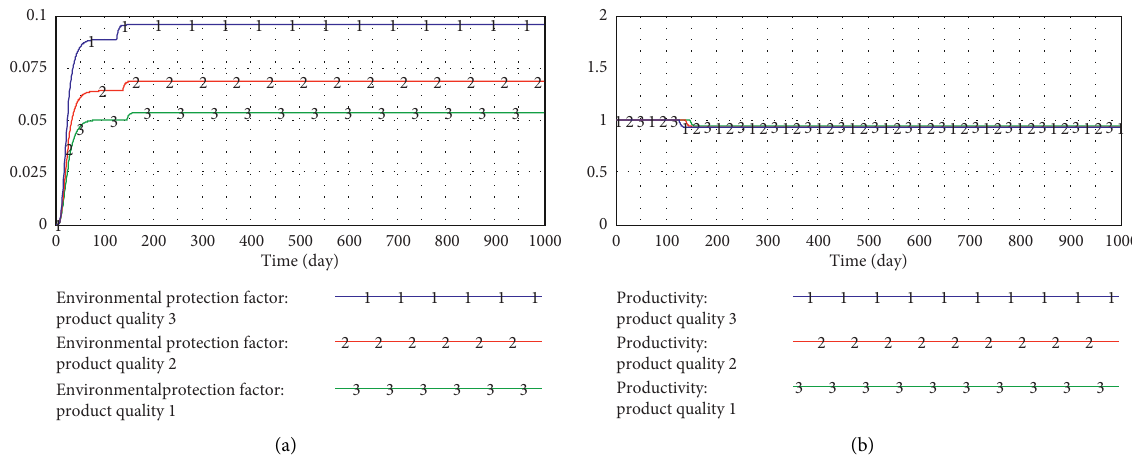
Figure 12: Simulation results of product quality as an influencing factor. Product quality 1 � 0.2; product quality 2 � 0.5; product quality 3 � 0. (a) Environmental production factor. (b) Productivity. Table 1: Product quality’s impact change on total reusability, productivity, and environmental index. Product